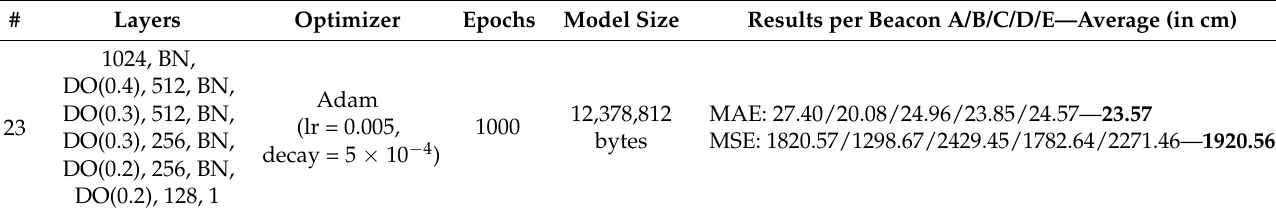
Table 11. Experiment No. 23 parameters and results.